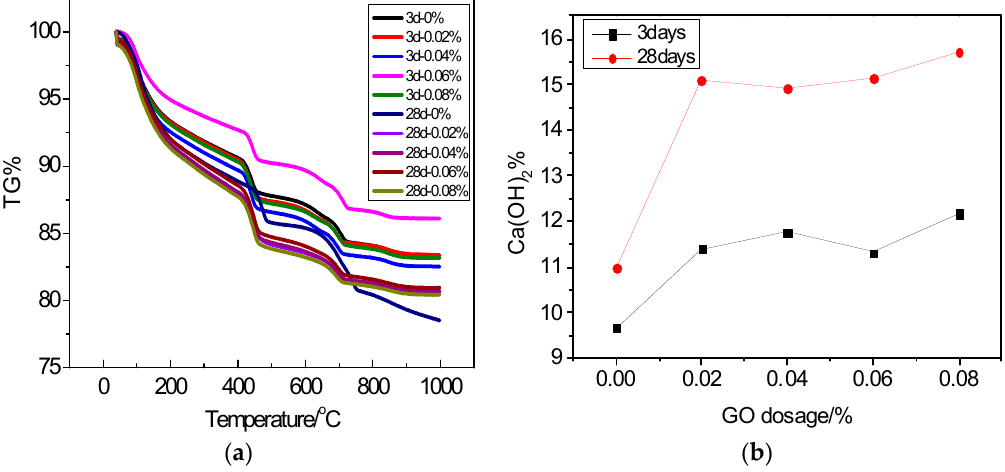
Figure 5. TG curves of cement pastes and mass loss of CH at different ages, ( a ) TG curves of cement paste and ( b ) mass loss of CH.